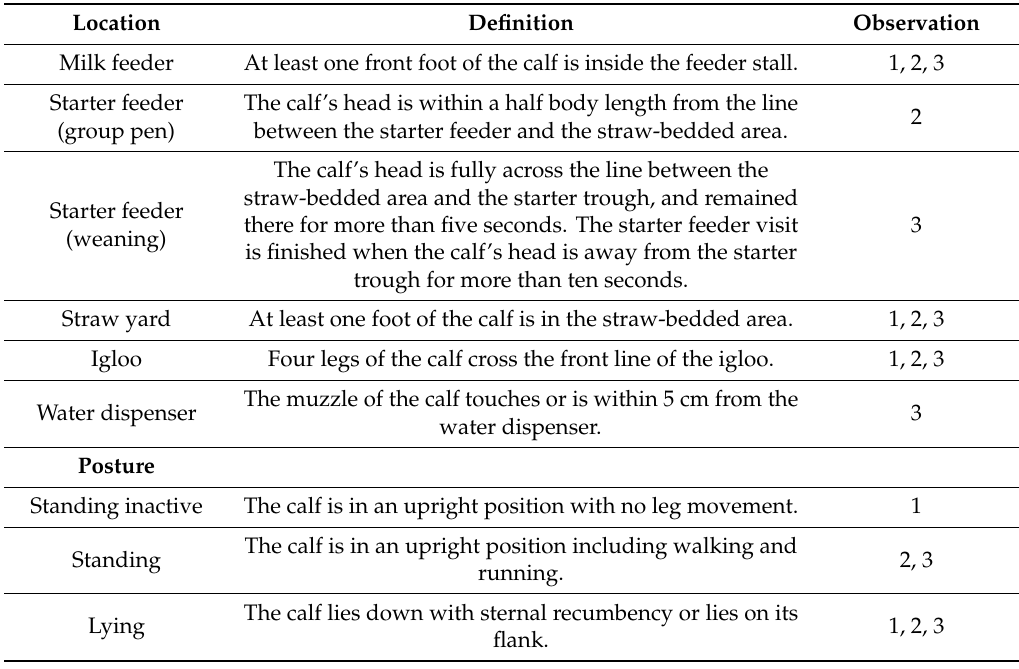
Table 1. Definitions of locations and postures, details of behaviours and event / states used for the observation of calf reactions to a group environment (1), calf behaviour in the first two weeks in the group pen (2), and calf reactions to weaning